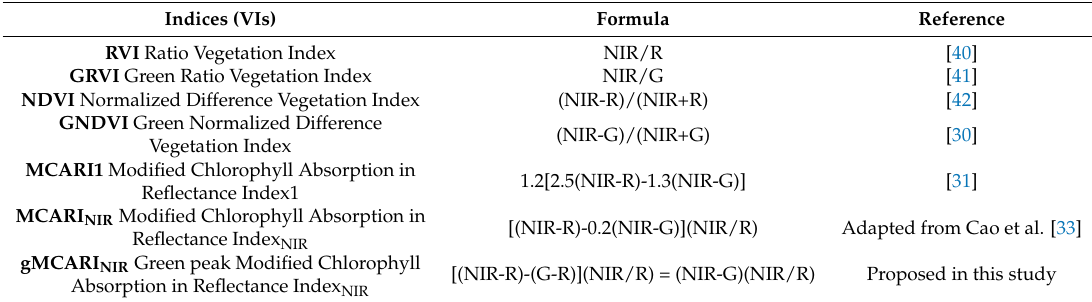
Table 2. Vegetation indices (VIs) evaluated in this study (Green-G: 550 nm, Red-R: 675 nm and Near Infrared-NIR: 780